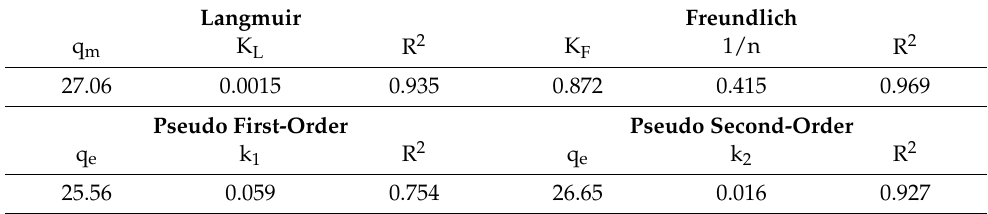
Pseudo second-order